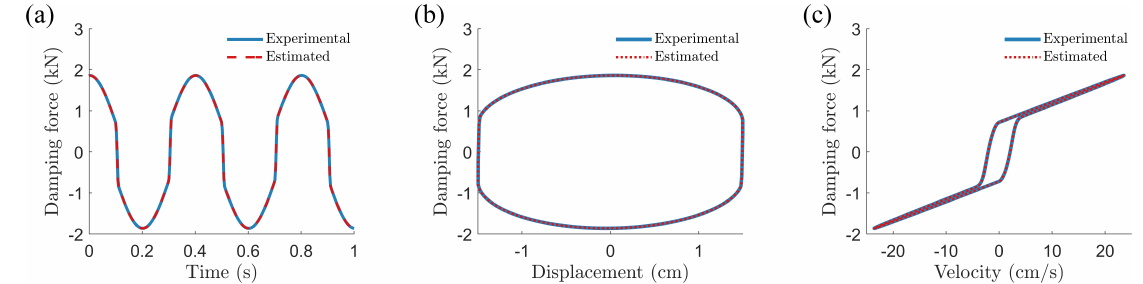
Figure 10. Experimental data and estimated response using identified parameters for magnetorheological damper system: ( a ) damping force over time, ( b ) displacement-level hysteretic response, and ( c ) velocity-level hysteretic response.